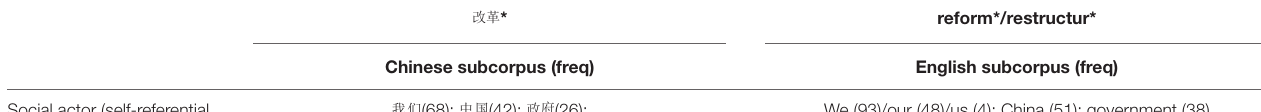
TABLE 6 | Collocates of reform*/restructur* in both subcorpora.